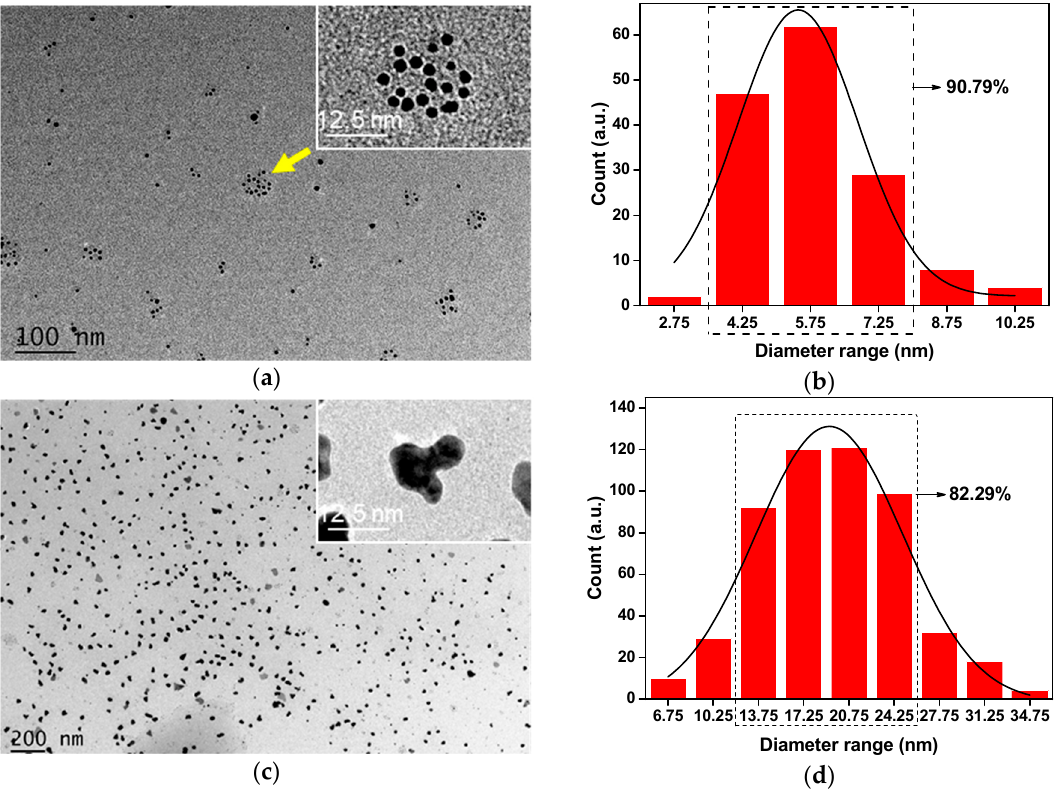
Figure 1. Morphology of Ag ‐ NPs: ( a , b ) TEM graph and particle size distribution of Ag ‐ NPs reacted 1 h; ( c , d ) TEM graph and particle size distribution of Ag ‐ NPs reacted 4 h.